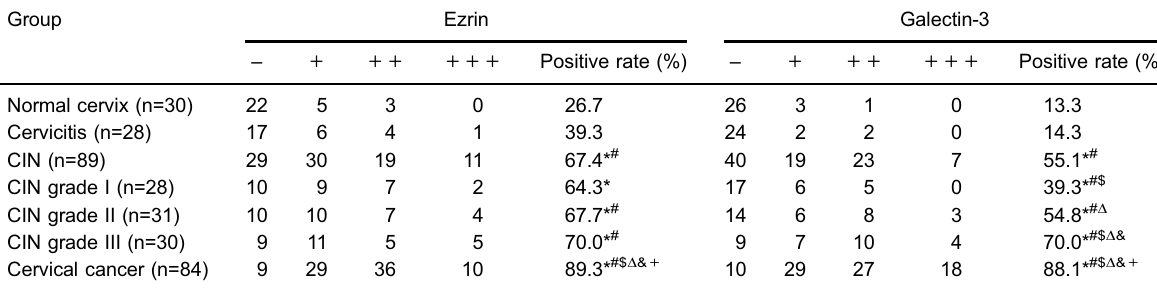
Table 2. Positive expression rate of ezrin and galectin-3 proteins in each group. Group